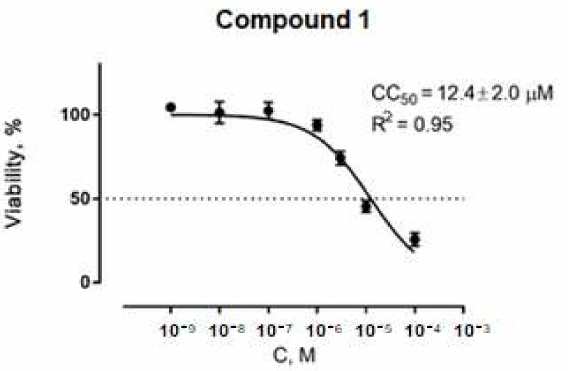
Figure 5. An effect of compound 1 at concentrations of 0.001–100 µ M on the metabolic activity (viability) of HepG2 cells during 48 h incubation in the MTT